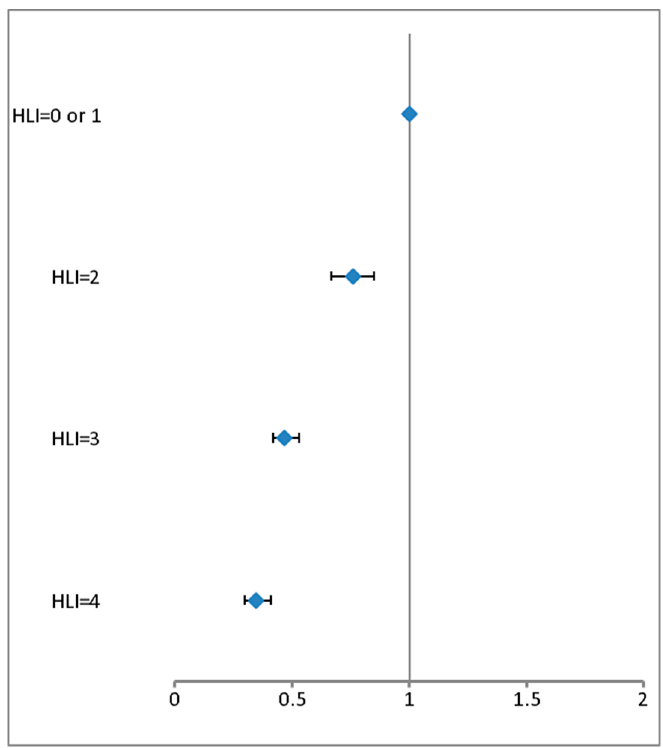
Figure 1. Multivariable-adjusted hazard ratios of incident Hypertension according to increasing number of Healthy Lifestyle Factors (HLI).